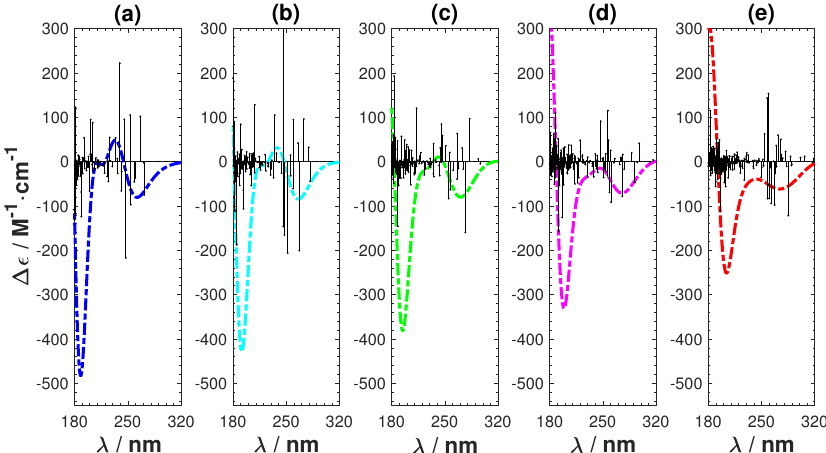
Figure 9. Transformation from CAM-B3LYP to B3LYP by changing the short- and long-range parameters. ( a ) CAM-B3LYP ( α = 0.19, β = 0.46 ) ; ( b ) α = 0.1925, β = 0.3450; ( c ) α = 0.1950, β = 0.23; ( d ) α = 0.1975, β = 0.1150; and ( e ) B3LYP ( α = 0.2, β = 0 )